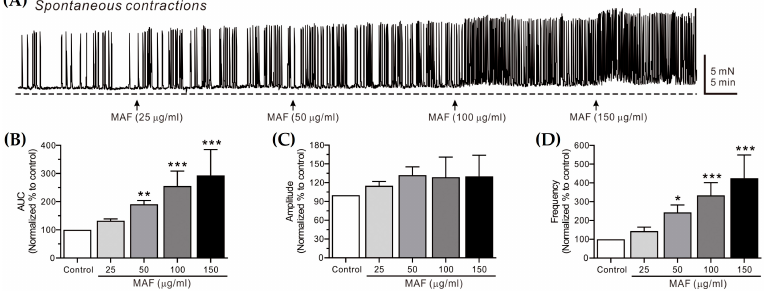
Figure 2. Effects of MAF on spontaneous contractions of smooth muscle strips in human ileum in situ. ( A ) Representative raw traces showing that MAF increased spontaneous contractions in a dose- dependent manner (25–150 µg/mL). Arrows indicate the points of MAF administration. Summarized graphs showing the effects of MAF on ( B ) AUC, ( C ) amplitude, and ( D ) frequency of spontaneous contractions. Significant difference (* p < 0.05, ** p < 0.01, and *** p < 0.001) compared with control.